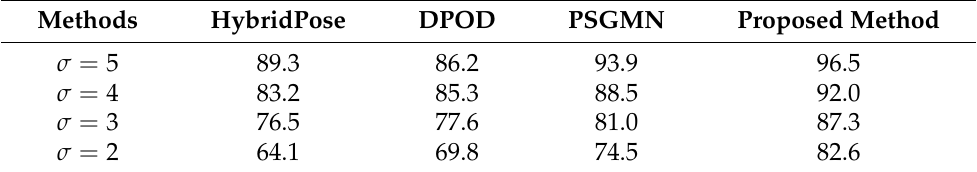
Table 1. Comparison of the proposed method with the other methods in terms of 2D Projection metric.